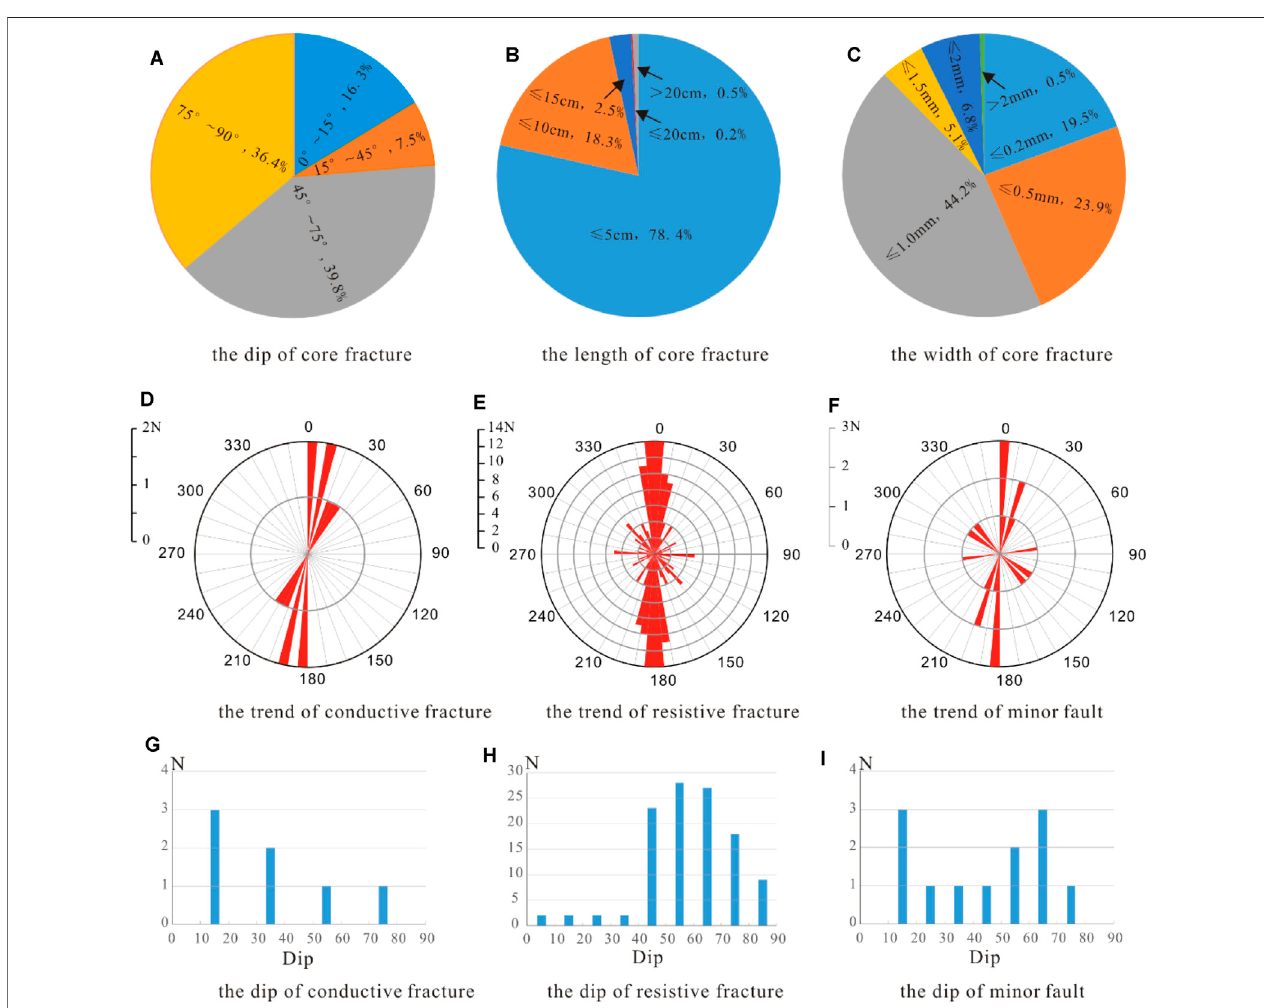
FIGURE8| ThecharacteristicparametersofthefracturesincoresofNiutitangshale.Thestructuralfracturesaredominatedbyhighdip-angleandverticalfractures (A) ; the fracture length ranges between 0 and 5 cm, followed by 5 – 10 cm (B) ; the fractures with aperture ≤ 1.0 mm are overwhelming (C) ; the high resistivity fractures strike in nearly NS with the dip angle of 52 ° (E,H) ; the high conductivity fractures and micro-faults mainly strike in NNE-SSW (D,F) , with the dip angle of 58 ° (G) in dominance and between 14 and 78 ° (I) , respectively.